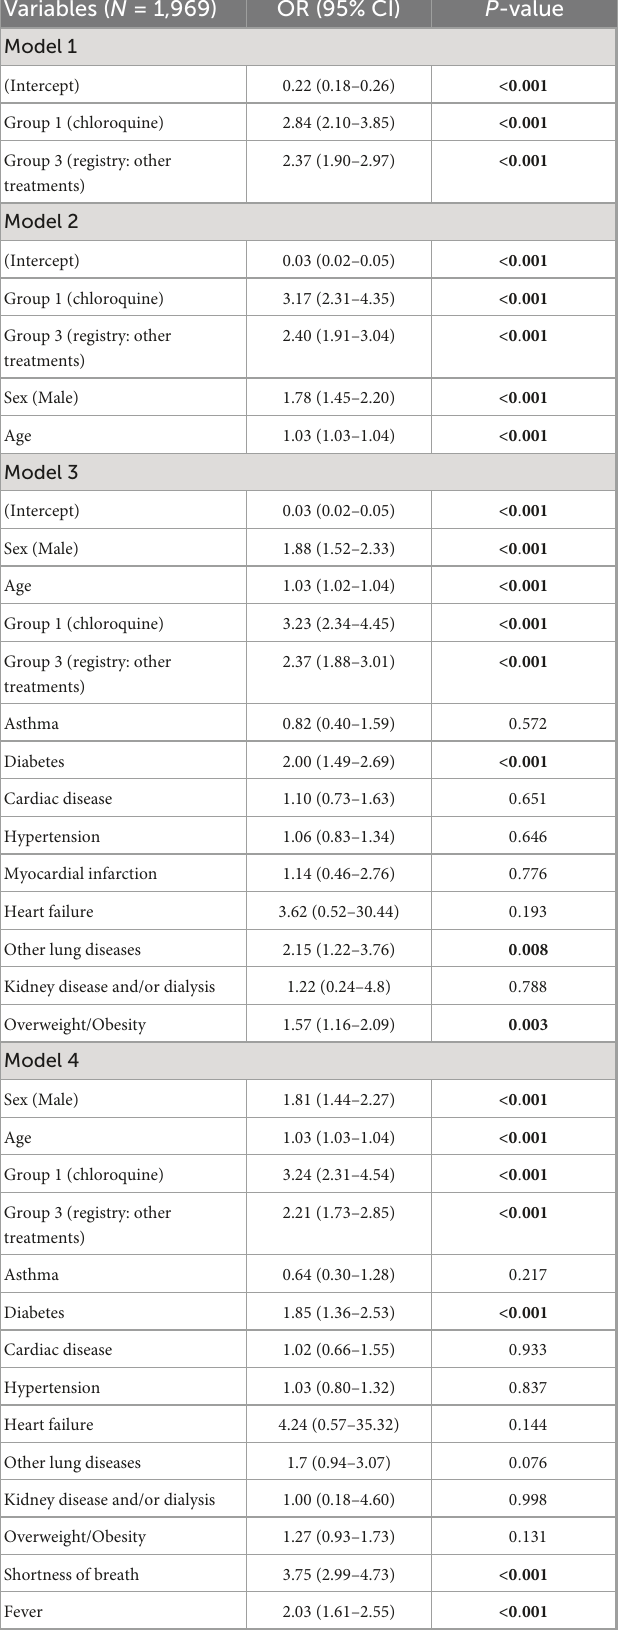
TABLE 3 Multivariate risk model for the composite primary outcome (hospitalization/ICU admission/mechanical ventilation/death) assessed by phone follow-up, adjusted for demographic, clinical, and COVID-19 presentation-related